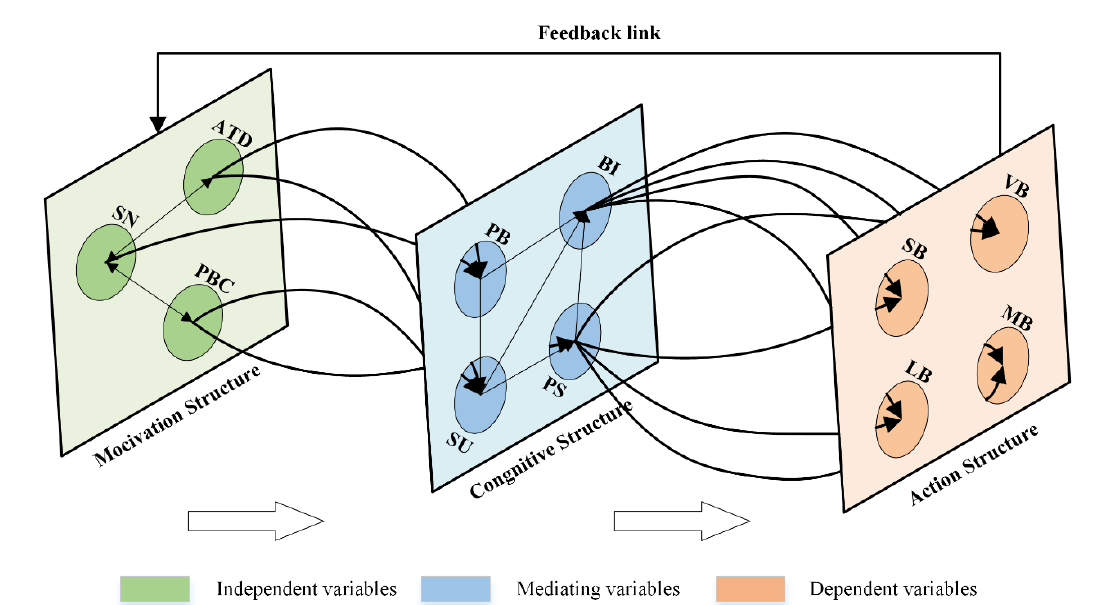
Figure 8. Structural model of the cognitive mechanism.